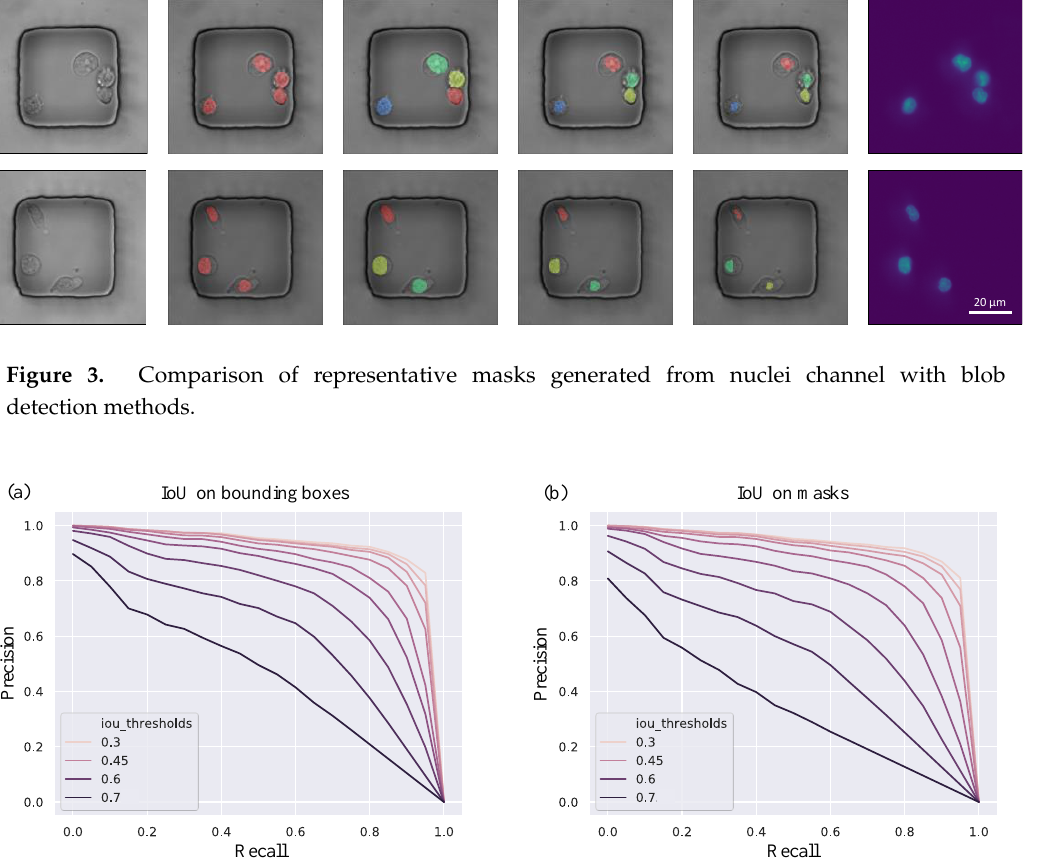
Figure 4. Precision-Recall curve with various IoU thresholds. ( a ) IoU is calculated based on bounding box of ragion of interests ( b ) IoU is calculated based on